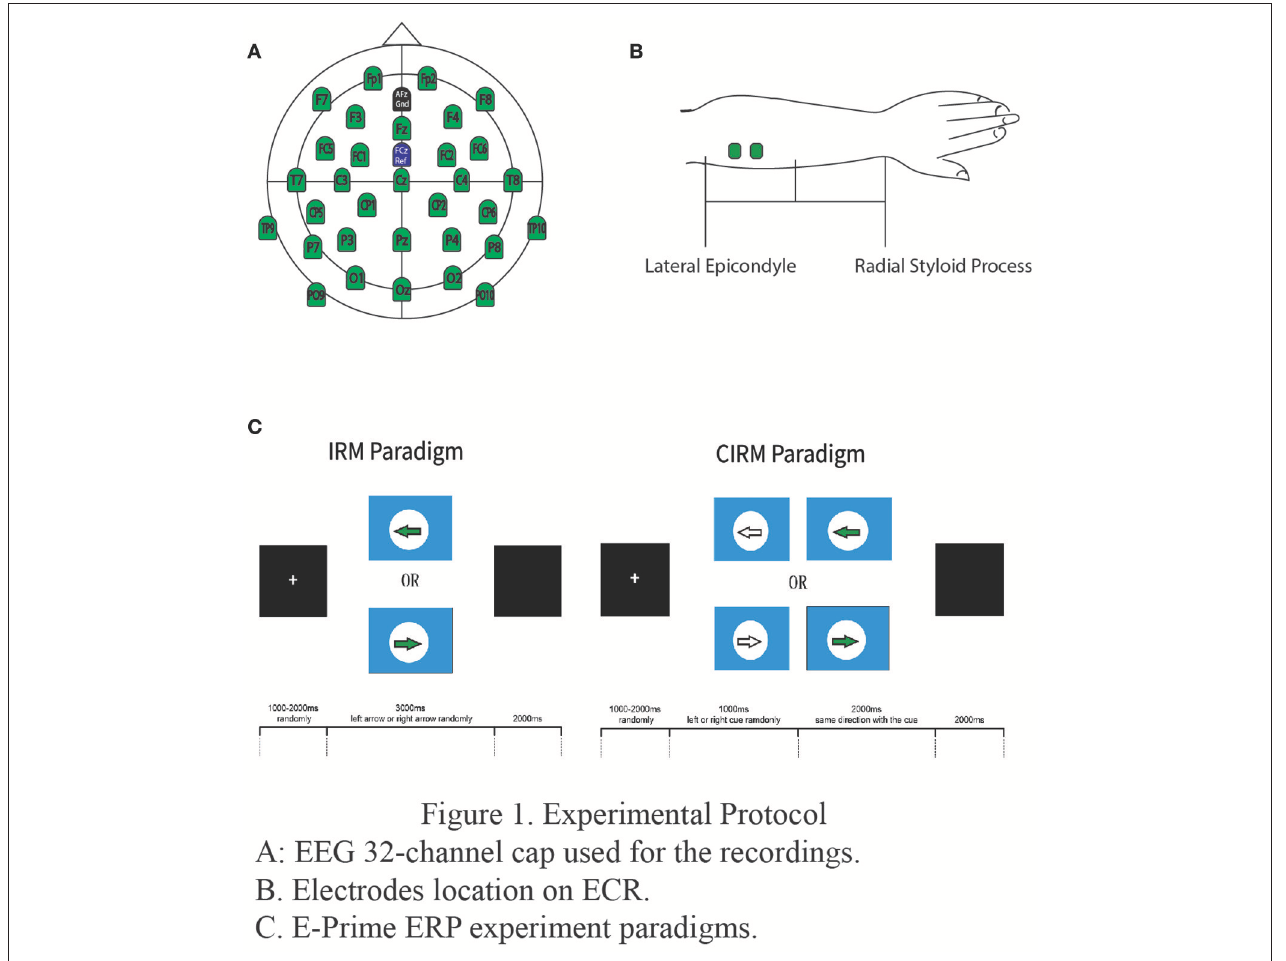
FIGURE 1 | Experimental protocol. (A) EEG 32-channel cap used for the recordings. (B) . Electrodes location on ECR. (C) . E-Prime ERP experiment